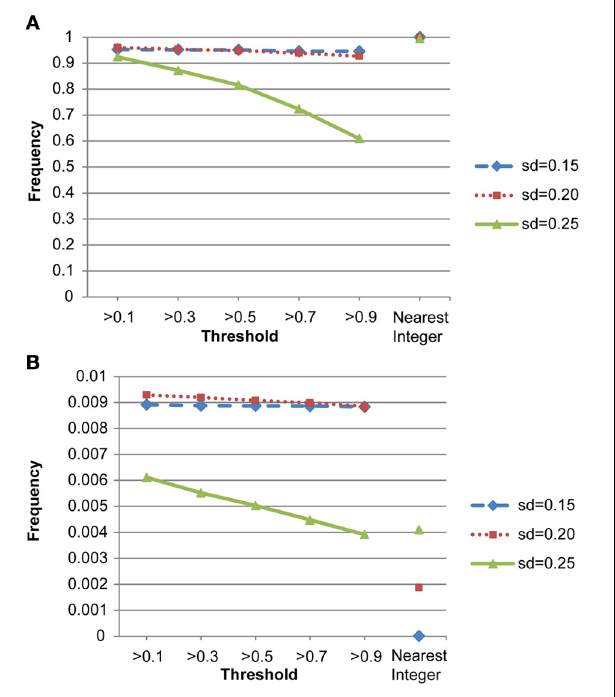
FIGURE 7 | (A) True positive rates of detecting de novo mutation families by the proposed model and the nearest integer method (the three points in the rightmost column). (B) False positive rates of detecting de novo mutation families by the proposed model and the nearest integer method (the three points in the rightmost